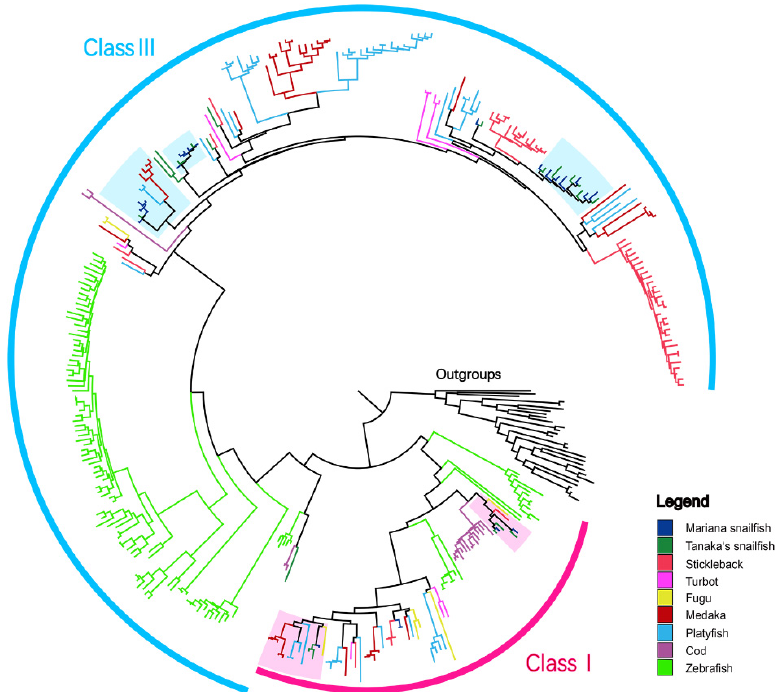
Figure 4. A phylogenetic tree of TAARs from nine fish species (legends are indicated on the right side of the figure). Lamprey aminergic receptors were used as an out-group. The orthologous groups containing both of the Mariana snailfish and Tanaka’s snailfish TAARs are indicated by shading.